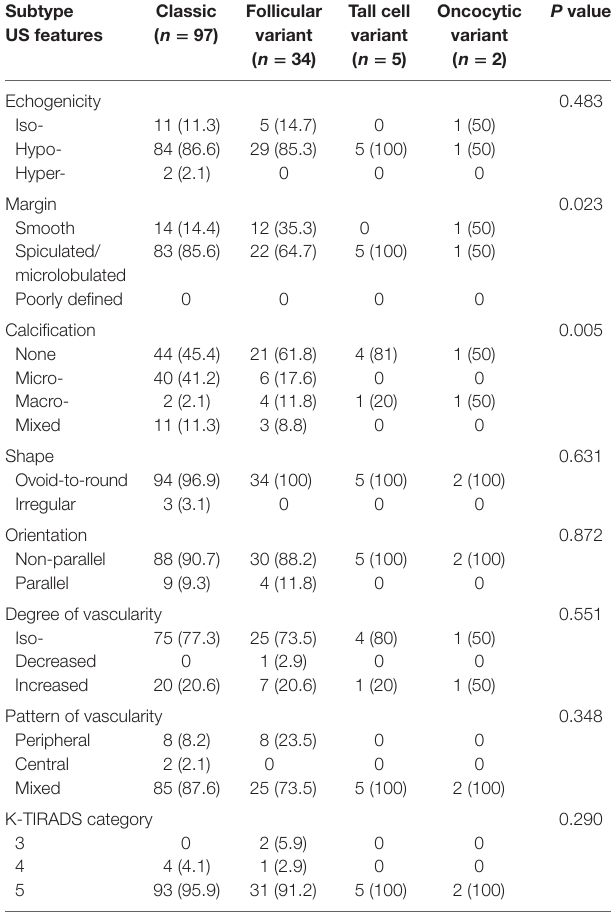
TaBle 1 | Comparison of ultrasonographic features of PTC according to the